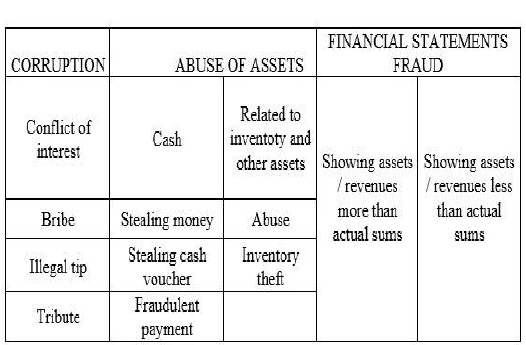
Table 1: Classification of Fraud